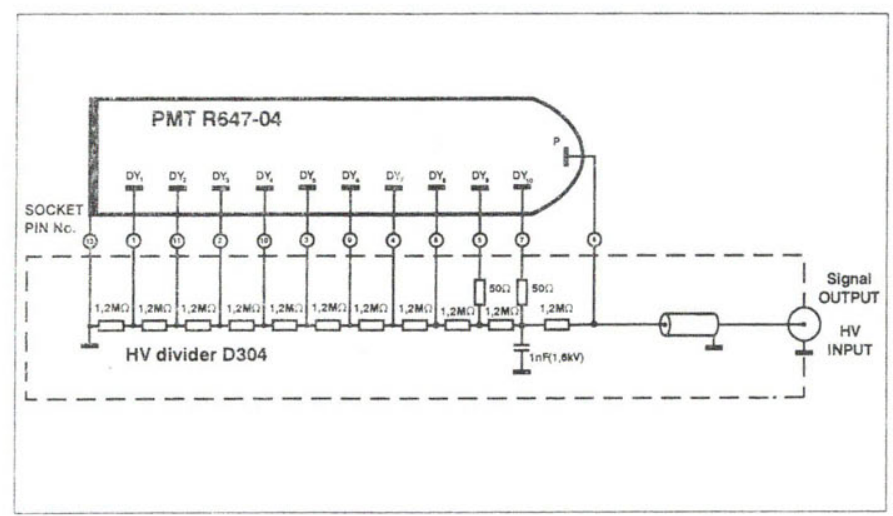
Fig. 5. A circuit-diagram of the D304 HV